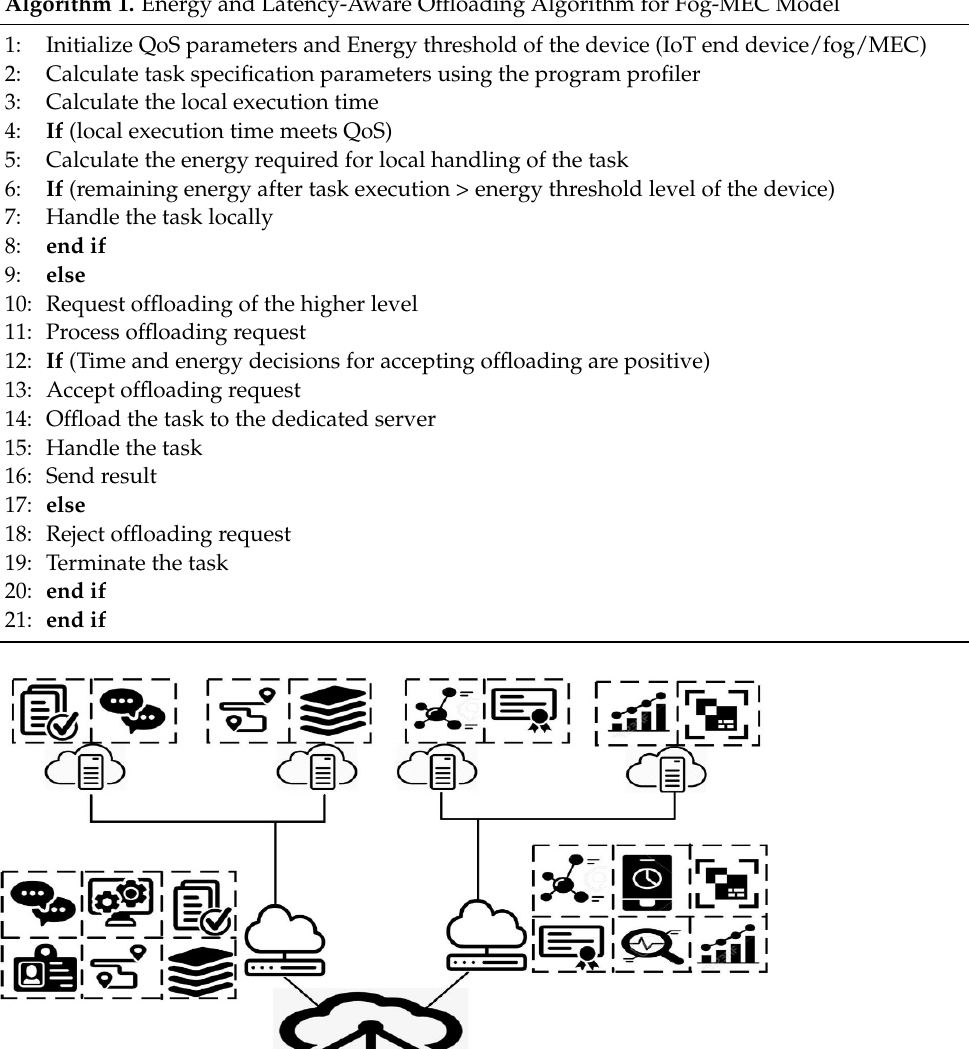
Algorithm 1. Energy and Latency-Aware Offloading Algorithm for Fog-MEC Model